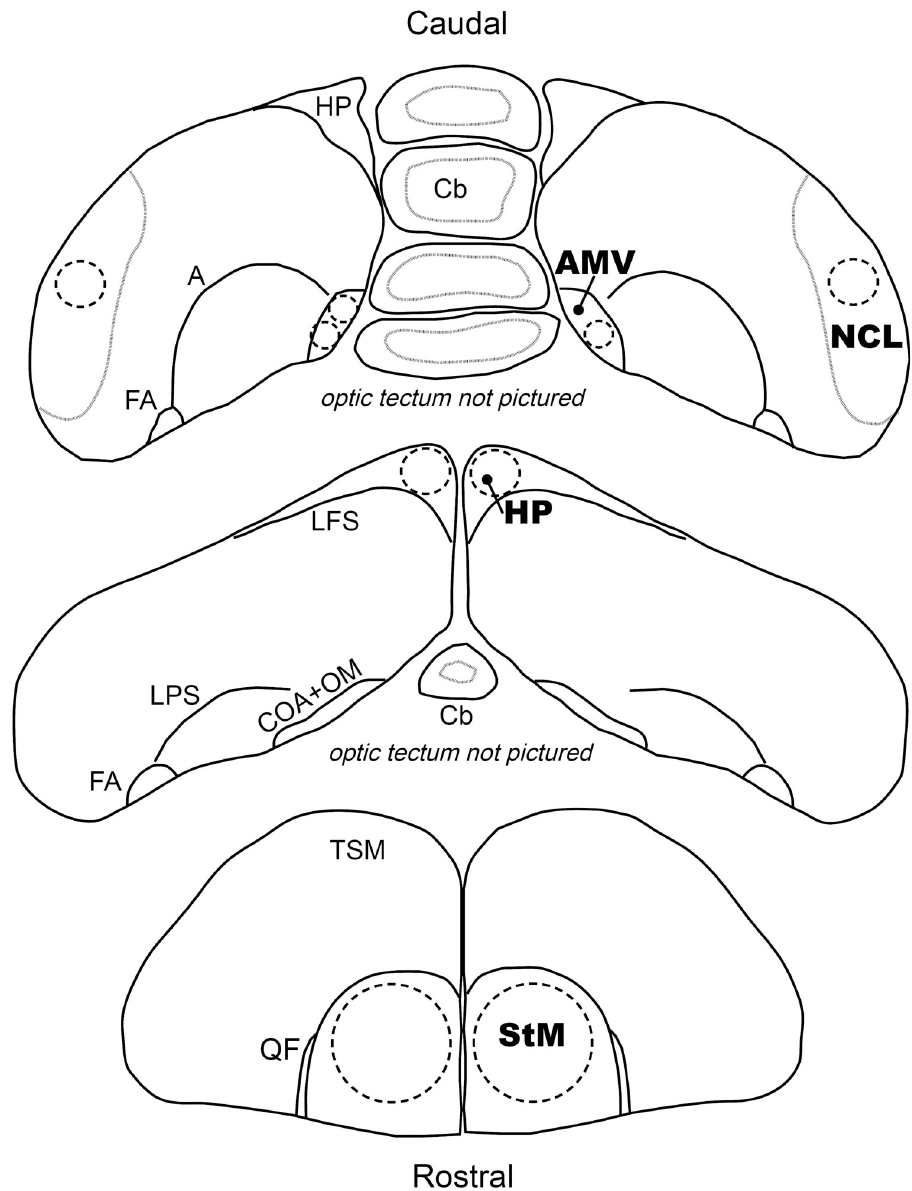
Fig 1. Locations of brain punches used for house sparrow RNAseq. Depiction of the approximate locations brain punches were taken from coronal 200 μ m sections and the corresponding regions used as landmarks. Top (caudal) : Medial ventral arcopallium (AMV) samples consisted of three 19 G punches and caudolateral nidopallium (NCL) samples consisted of two 15 G punches. The NCL was sampled on the following section after AMV, but the regions are pictured on the same slice for simplicity. Middle : Caudal dorsomedial hippocampus (HP) samples consisted of two 15 G punches. Bottom (rostral): Striatum (StM) samples consisted of two 11 G punches. Abbreviations : Cb = cerebellum, A = arcopallium, FA = tractus fronto-arcopallialis, LFS = lamina frontalis suprema, LPS = lamina pallio-subpallialis, COA = anterior commissure, OM = tractus occipito-mesencephalicus, TSM = tractus septopallio-mesencephalicus, QF = tractus